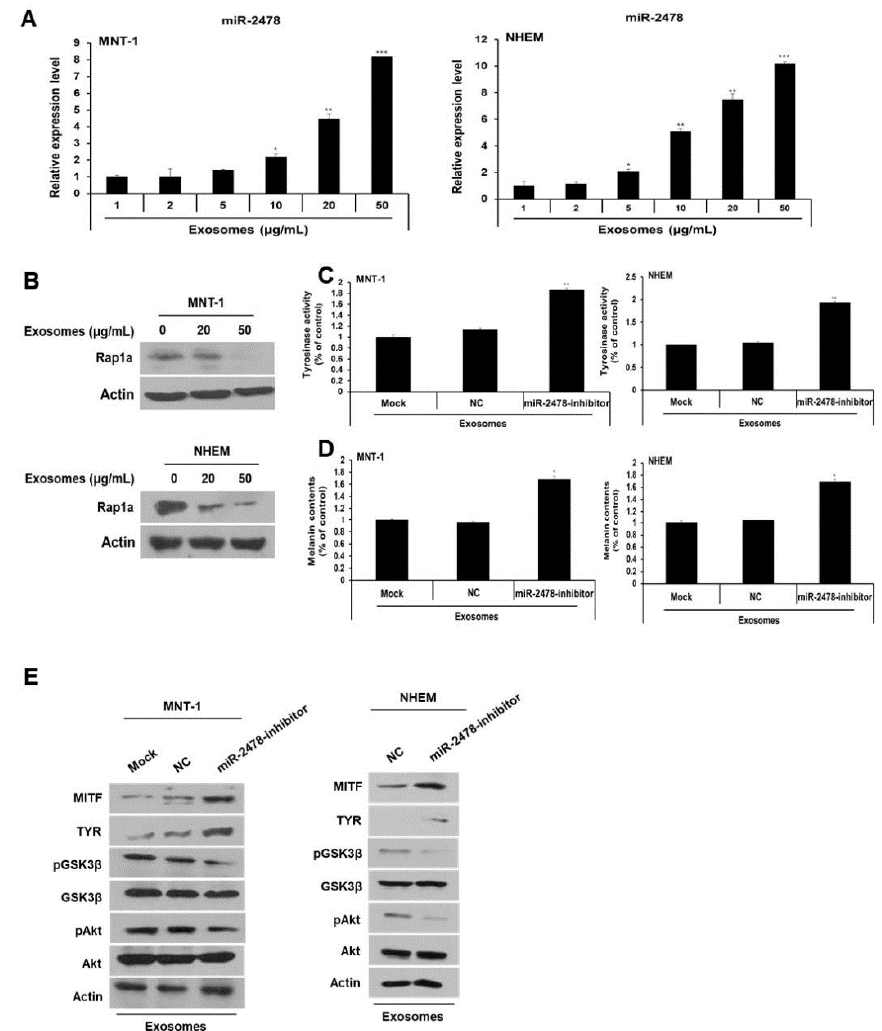
Figure 9. miR-2478 inhibits melanogenesis in human melanoma cells and melanocytes. ( A ) MiR-2478 expression levels in cells treated with milk exosomes were measured by qRT-PCR; n = 3, * p < 0.05, ** p < 0.01, *** p < 0.001. ( B ) The Rap1a protein level in milk exosome-treated cells was assessed by Western blotting. ( C , D ) Tyrosinase activity and melanin contents were examined in the negative control (NC) or miR-2478 inhibitor-treated cells with 50 μ g/mL of exosomes; n = 3, * p < 0.05. ** p < 0.01. ( E ) Protein levels of MITF, TYR, pAkt, total Akt, pGSK3 β and total GSK3 β in NC or miR-2478 inhibitor- transfected cells exposed to milk exosomes were measured by Western